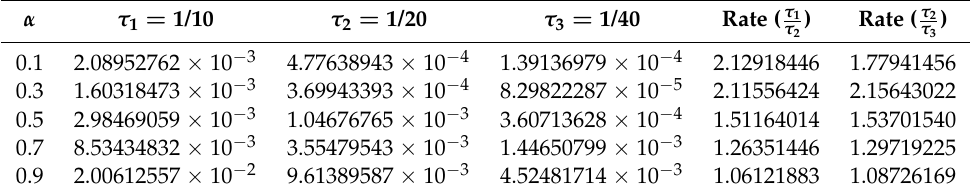
(cid:107) u ( t n ) − u n n